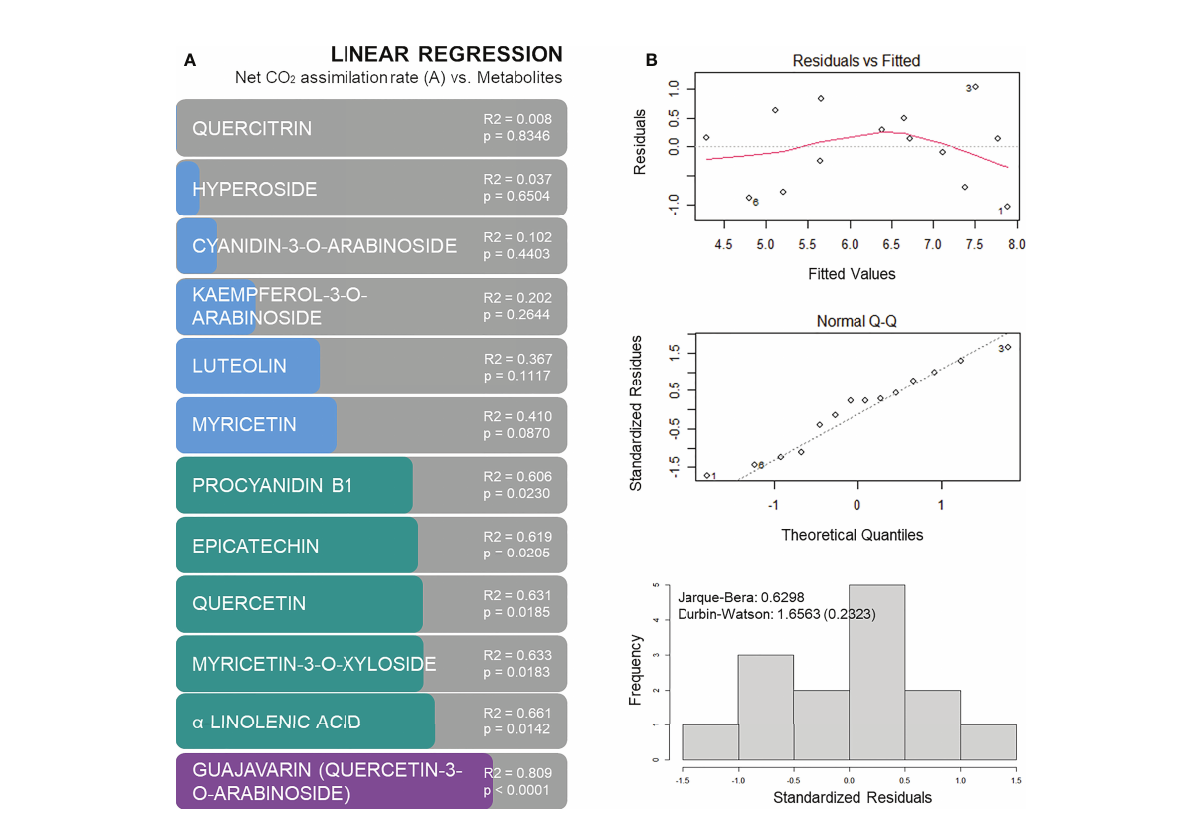
FIGURE 8 Regression models based on metabolites concentration to predict net CO 2 assimilation rates: R 2 of linear regression analysis with p-values (A) , and residuals versus fi tted plot, Q-Q plot and histogram of residuals with Jarque-Bera and Durbin-Watson tests for linear regression between net CO 2 assimilation and guajavarin (quercetin-3-O-arabinoside) concentrations (B)